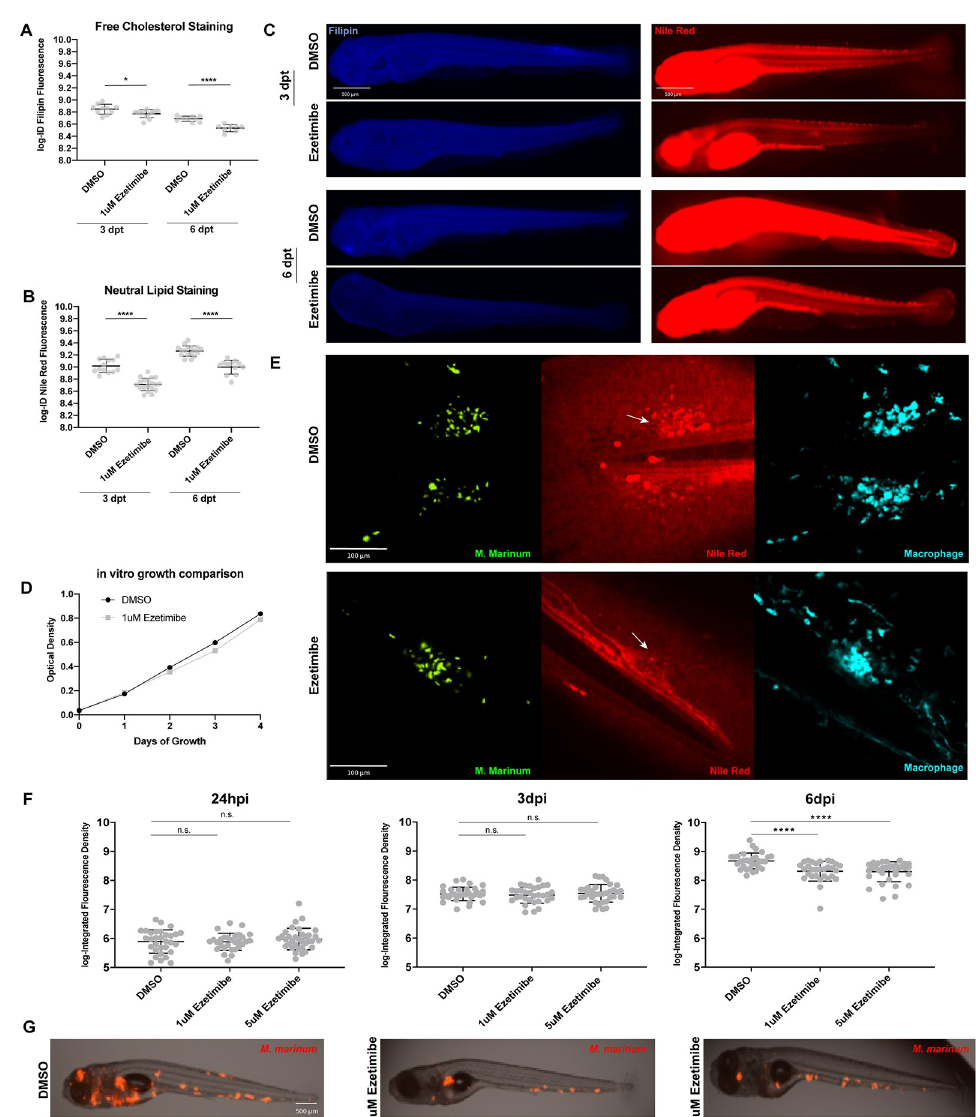
Fig 3. Ezetimibe treatment results in reduced neutral lipid accumulation and reduced infection burden. a . Comparison of integrated density of filipin fluorescence in the tail region of animals treated with vehicle alone (0.5% DMSO) or 1 μ M ezetimibe. Data were collected at 3 and 6 days post-treatment (dpt). Student’s t-test � p = 0.018, ���� p < 0.0001 b . Comparison of integrated density of Nile red fluorescence in the tail region of animals treated with vehicle alone (0.5% DMSO) or 1 μ M ezetimibe. Data were collected at 3 and 6 dpt. Student’s t-test ���� p < 0.0001 c . Animals representing the median values from comparison groups in (a) and (b). Bar = 500 μ m. d . Four-day time course of bacterial growth in vitro . Culture was maintained in either vehicle alone (0.5% DMSO) or 1 μ M ezetimibe. No significant differences in bacterial growth were observed, Pearson R-squared = 0.99. e . Representative images of larval tail fins 2dpi in the absence or presence of ezetimibe treatment. Arrows indicate location of infection foci with (DMSO) or without (ezetimibe) neutral lipid accumulation. Bar = 100 μ m f . Comparison of infection burden at 24 hpi, 3 dpi, and 6 dpi in animals treated with vehicle alone (DMSO), 1 μ M and 5 μ M ezetimibe. No statistically significant differences were observed between groups at 24 hpi and 3dpi. One- way ANOVA with Tukey’s multiple comparisons ���� p < 0.0001. Representative of four independent experiments. g . Animals representing the median values from 6 dpi comparison groups in (f).